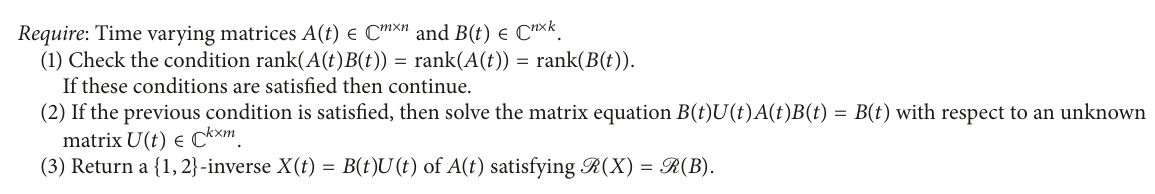
Algorithm 6: Computing a {1,2} -inverse with the prescribed